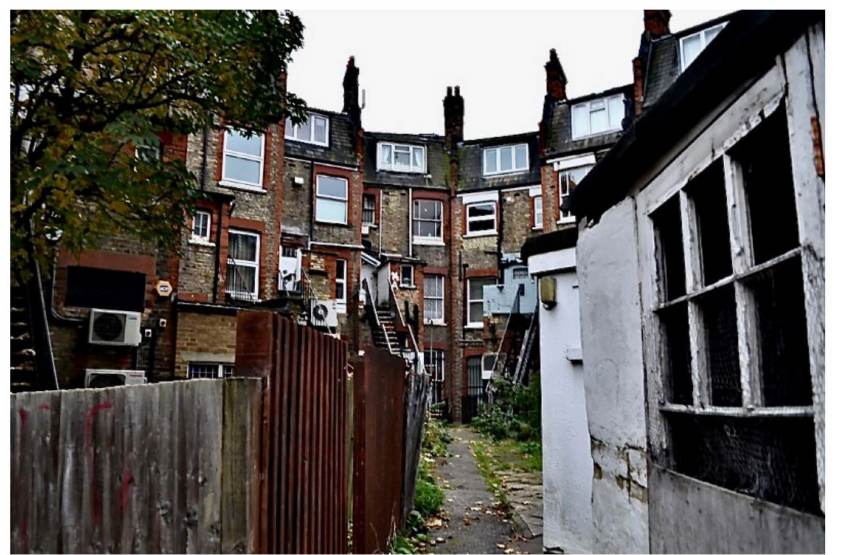
Figure 25. House